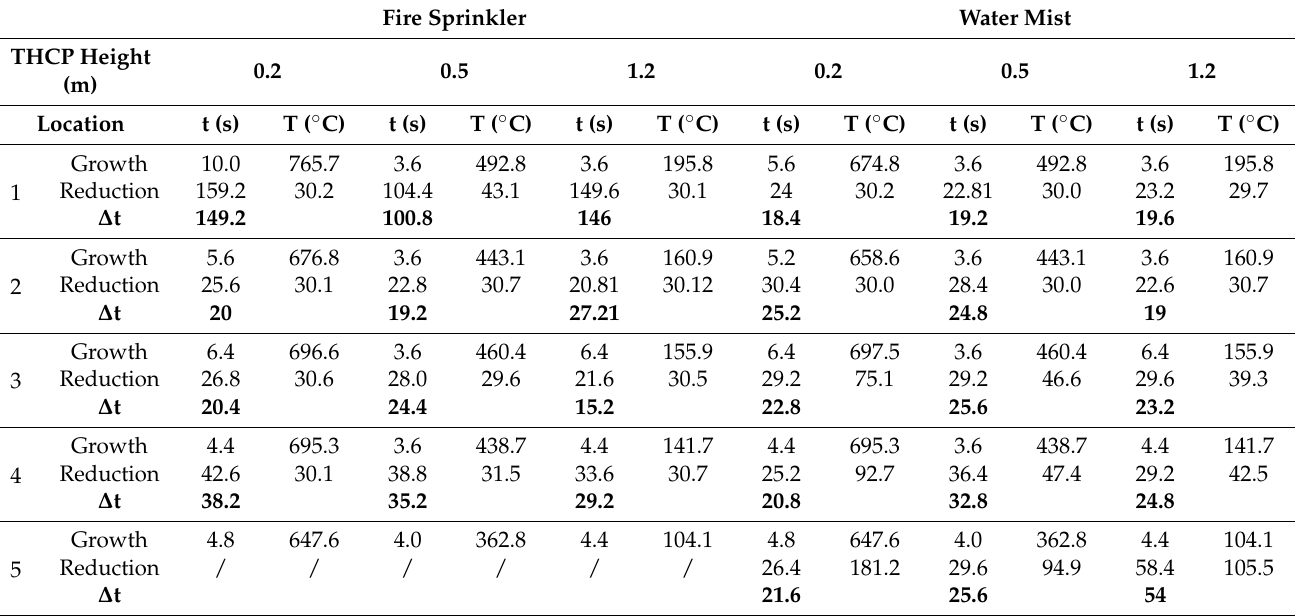
Table 3. Summary of key temperature and time for both systems. Fire Sprinkler Water